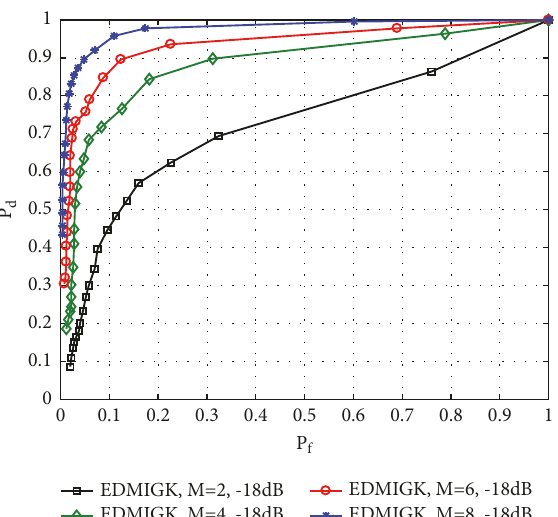
Figure 8: The ROC curve with different numbers of SUs under 𝑆𝑁𝑅 = −18 dB.